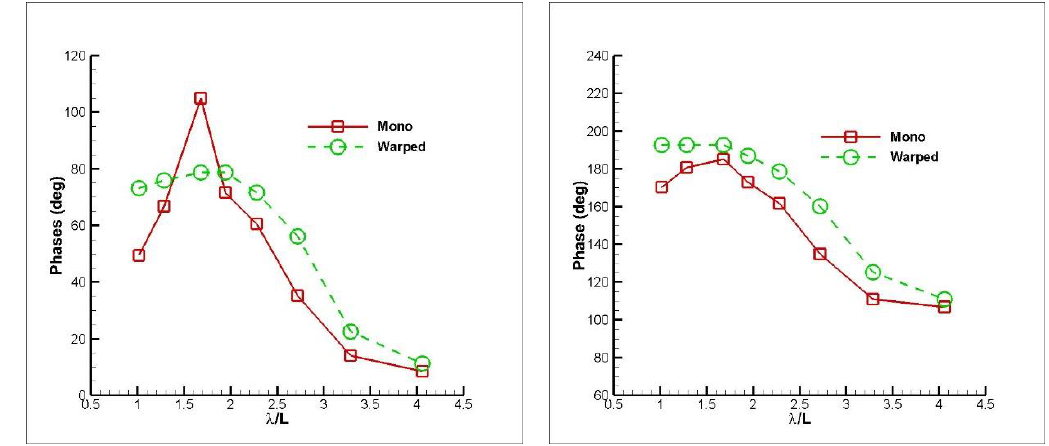
Figure 12. Phases of heave ( left ) and pitch ( right ) for both models at Fn B = 1.67.